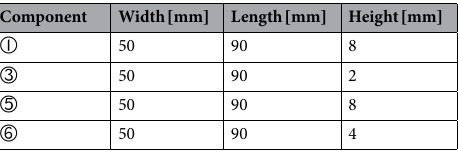
Table 1. Dimensions of the components of the evaluation setup shown in Fig. 3.